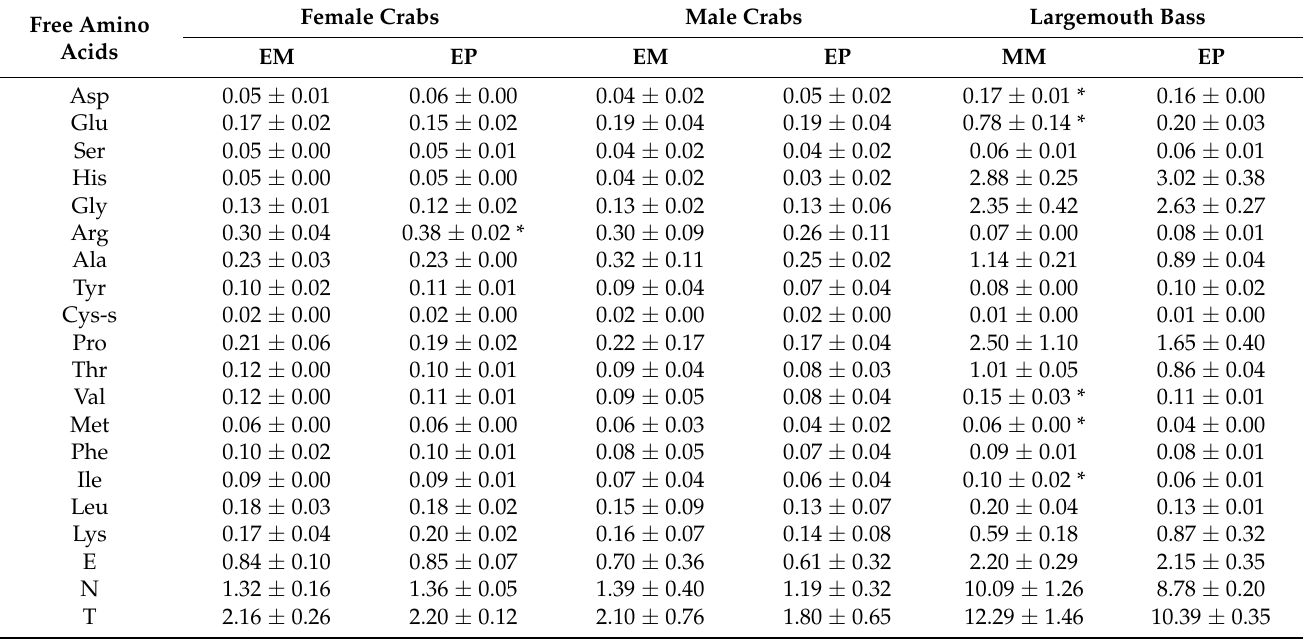
Table 6. FAAs (g/100 g tissue) detected in the muscles of Chinese mitten crabs and largemouth bass cultured in the EM, MM, and EP groups. Values are means ± SD ( n =